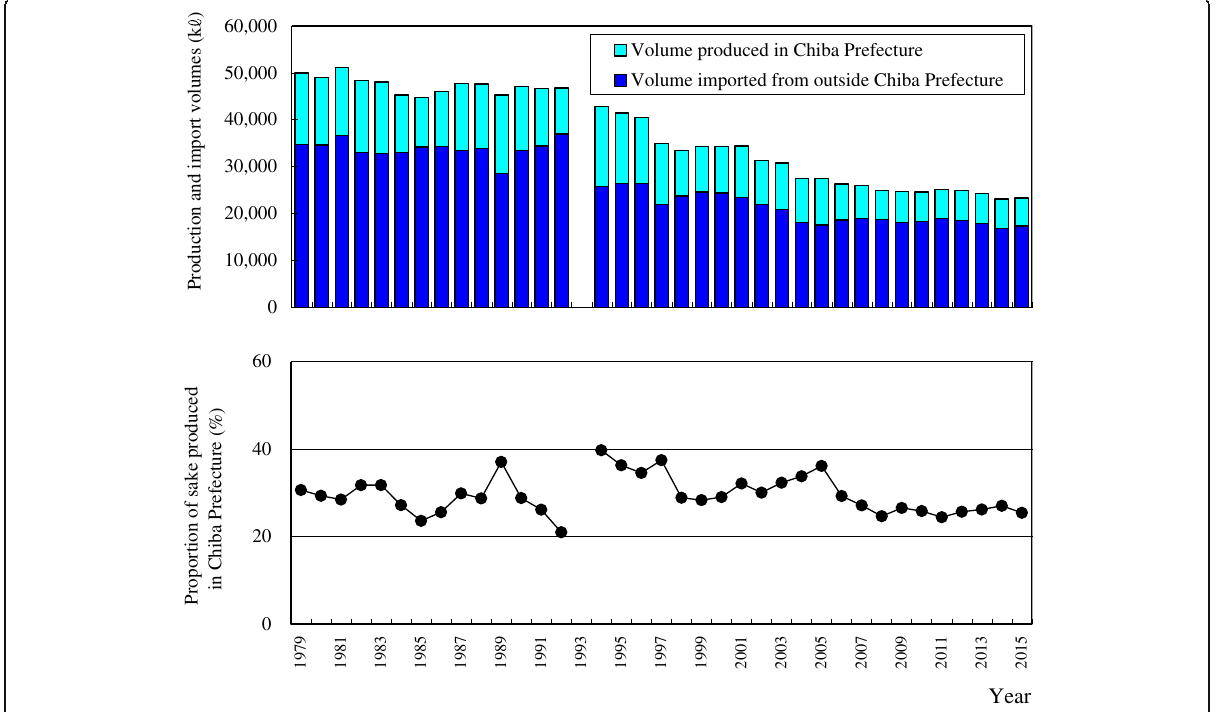
Fig. 12 Sake volume produced in Chiba Prefecture and imported from outside the prefecture. Source: (National Tax Agency HP https://www.nta.go.jp/kohyo/tokei/kokuzeicho/jikeiretsu/01.htm) Data for 1993 was unavailable